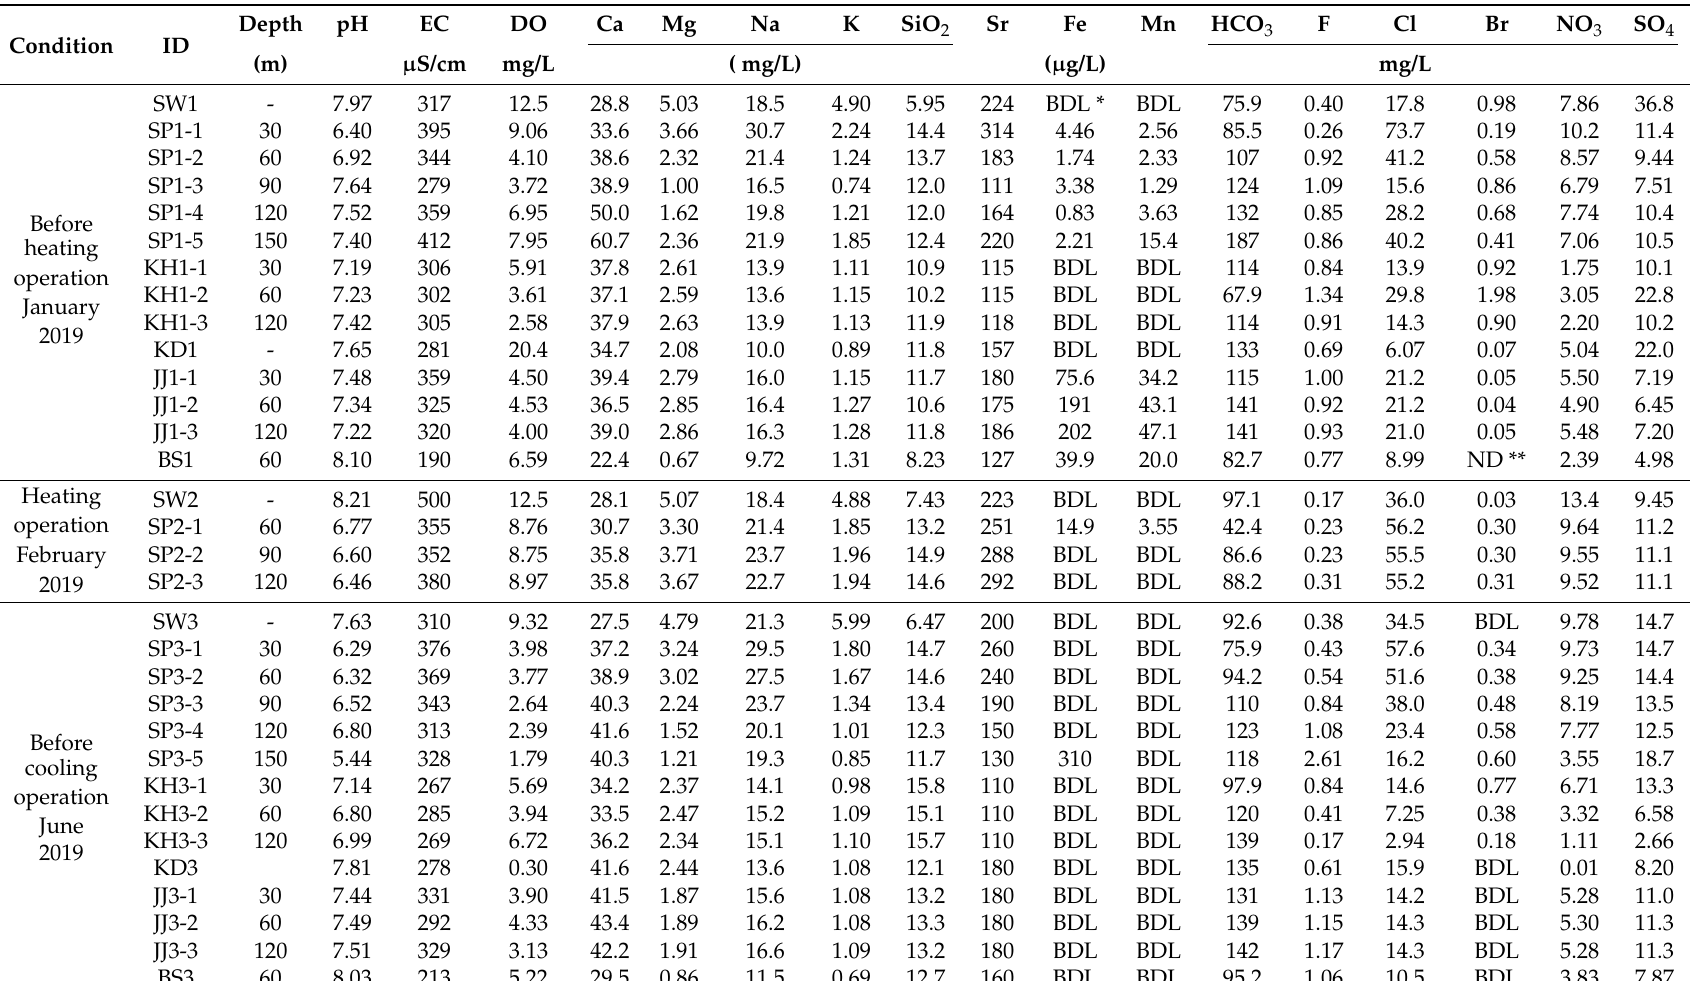
Table 1. Field-measured values and hydrochemical data of the water